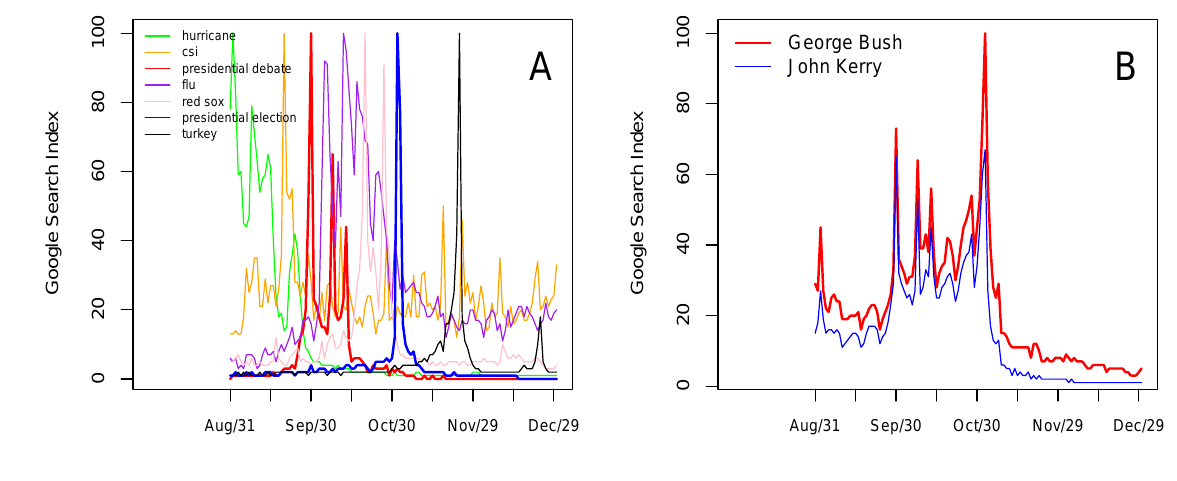
Figure 1: Issue-attention cycles in the fall of 2004 based on Google Trends analysis. Note: The Google search index, obtained by Google Trends analysis, shows the share of queries for the search keyword with respect to the total volume of queries for each particular keyword within four months (September 1st through December 31st) in the United States. In panel A, the maximum query share in the specified time period is normalized to be 100 for each search term during the period. Therefore, the meaningful comparison is between different moments in time within a particular search and not between different searches within a particular moment in